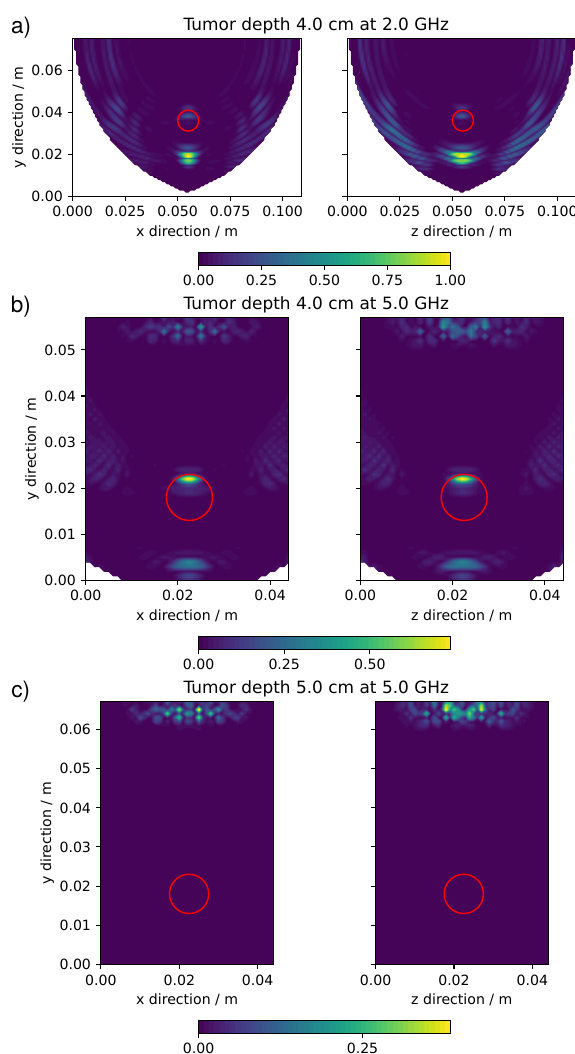
Figure 6. The 5 × 5 confocal maps showing particular artifacts and features. ( a ) ghost-like artifact for a 4 cm deep target at 2 GHz. ( b ) undersized target for a 4 cm deep target at 5 GHz. ( c ) no target for a 5 cm deep target at 5 GHz with a 3 × 3 antenna grid.